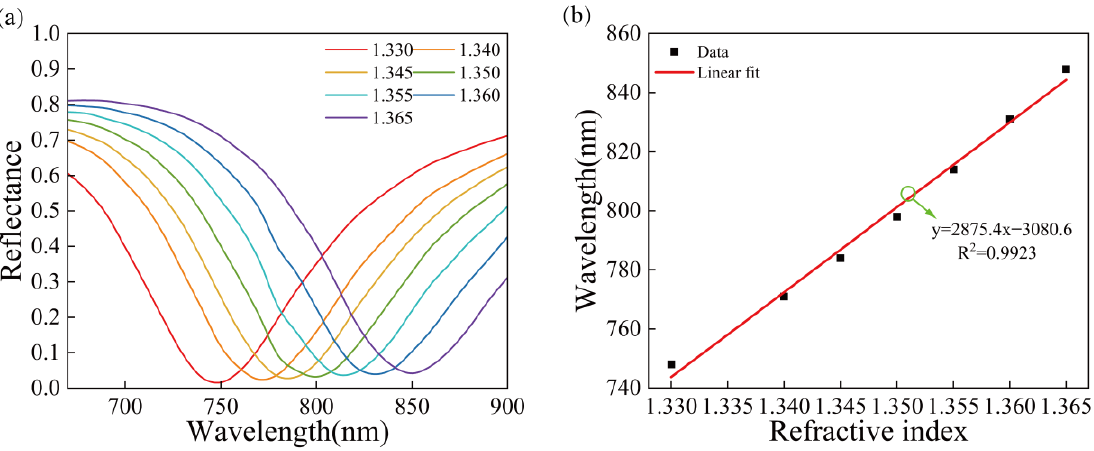
Figure 9. The reflectance curves of the Au/SiO 2 nanosphere structure, ( a ) SPR curves of the Au/SiO 2 nanosphere structures with different refractive indices, ( b ) relationship between the refractive index and the resonance wavelength and the corresponding linear fitting.